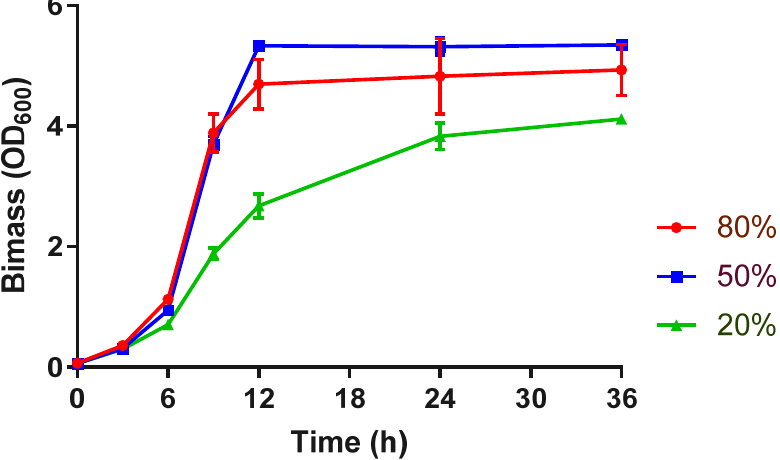
Figure 2. Growth curve of Z. mobilis under different conditions. 20%, 50%, and 80% represented corresponding conditions that 100-mL shake flasks contained 20, 50, or 80 mL RMG5, respectively. Values are the means of experiments with three or more technical replicates; error bars are standard deviations.